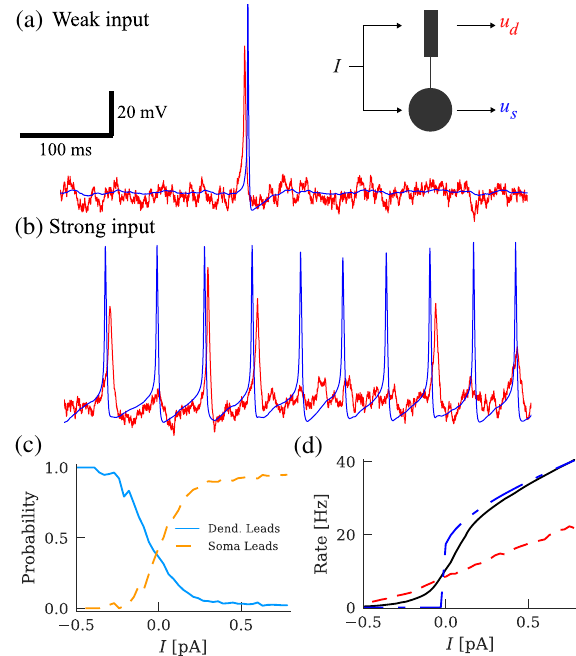
FIG. 1. Exchange of leadership in a simplified biophysical model of the dendrite-soma system. (a) The dendrite-soma system (see the Appendix) receiving a weak input in both the dendrite and the soma. The membrane potential of the soma (blue trace) and the dendrite (red trace) shows action potentials initiated first in the dendritic compartment. (b) For a strong input, the somatic compartment fires regularly and generally leads the dendritic action potentials. (c) The fraction of somatic spikes that are preceded by a dendritic spike within 8 ms (blue full line) and the fraction of dendritic spikes that are preceded by a somatic spike by at least 8 ms (orange dashed line) are shown. Spike timing is taken to be the time of crossing − 30 mV from below. (d) The firing rate of the coupled system is shown as a function of the input strength (black full line). Isolating the compartments by fixing the coupling conductance to zero shows that the dendrite- soma system interpolates between the isolated dendritic compart- ment (red dashed line) and the isolated somatic compartment (blue dash-dotted